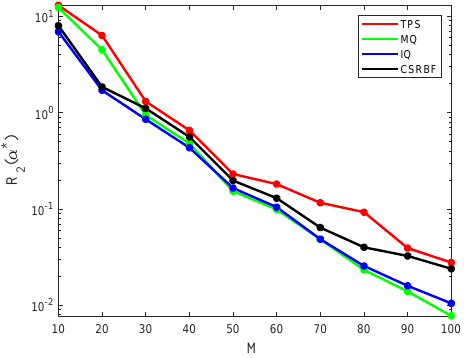
Figure 4. The graph of the variety of R 2 ( α ∗ ) with M corresponding to the four kinds of basis functions under N = 5000.